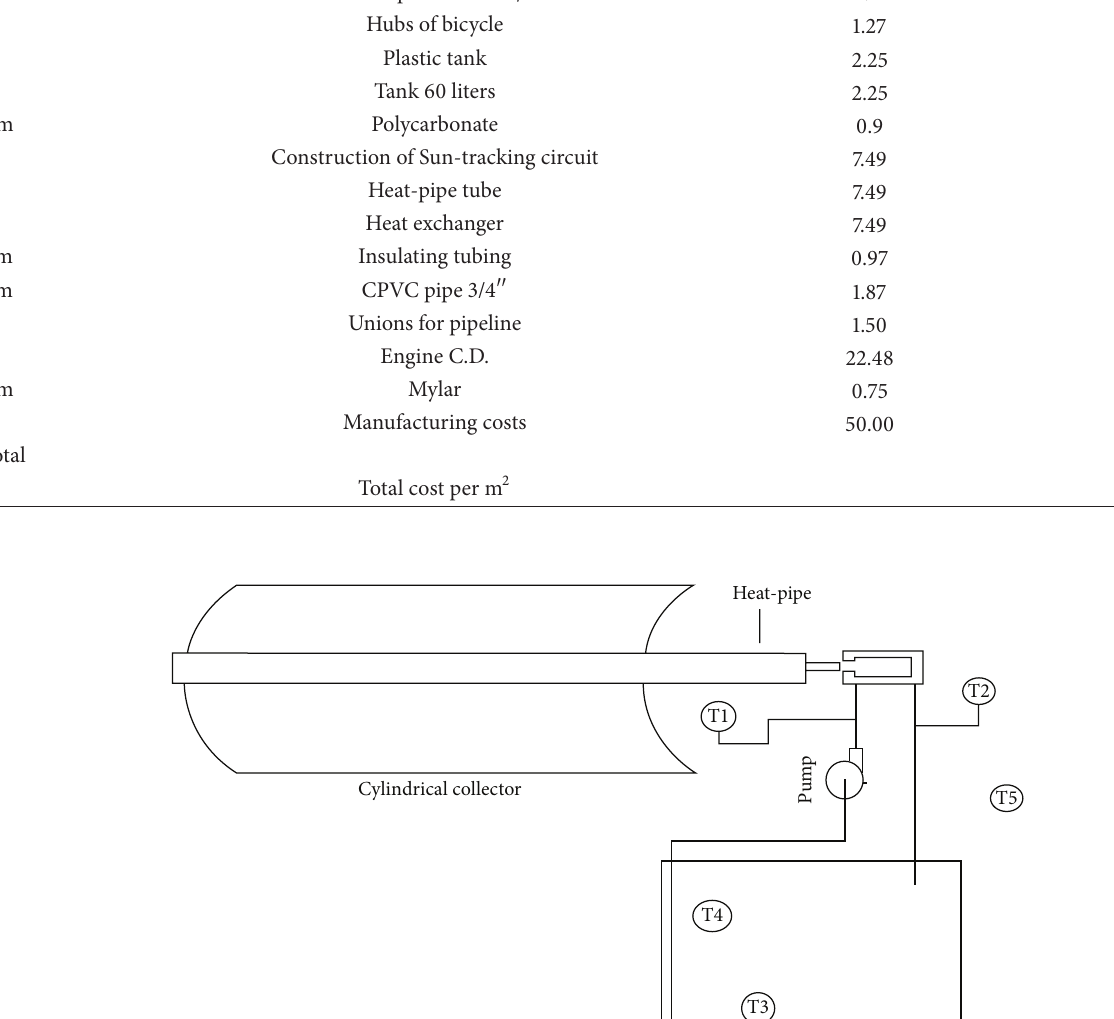
Figure 5: Diagram of the experimental